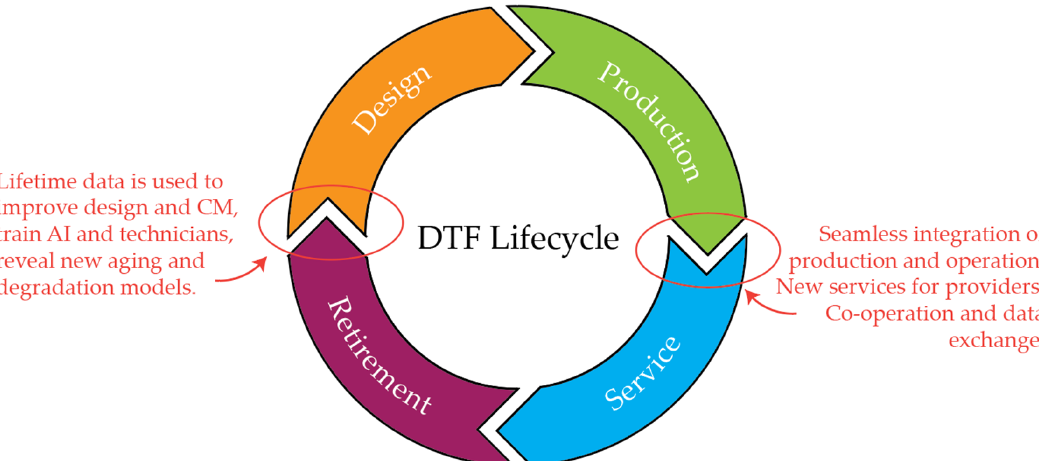
Figure 7. Proposed DTF lifecycle. The data layer allows for storage and improvement, making the lifecycle essentially circular.